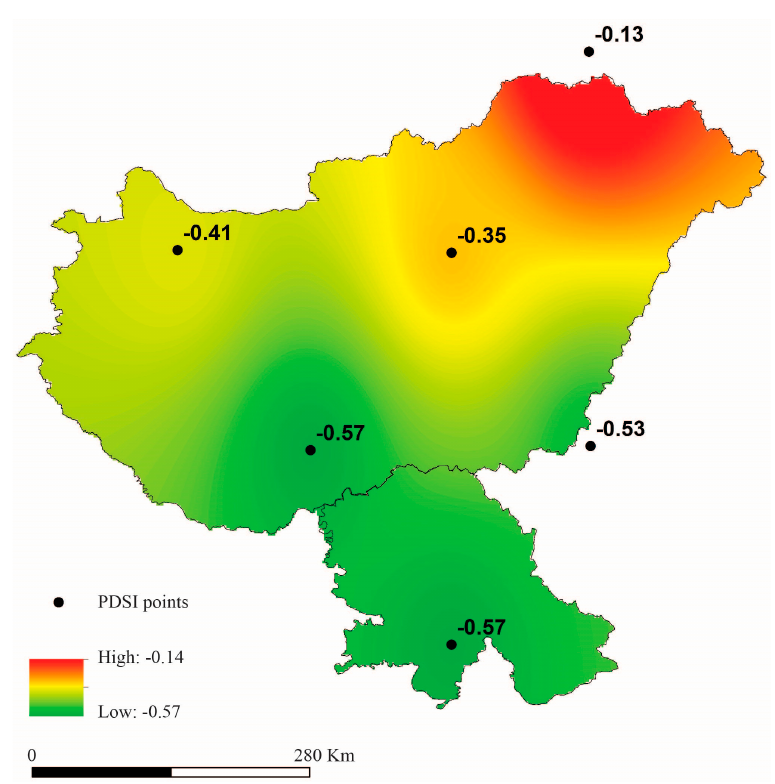
Figure 6. The spatial distribution of the annual Palmer Drought Severity Index for Hungary and Vojvodina, presented jointly during the period 1920–2014.